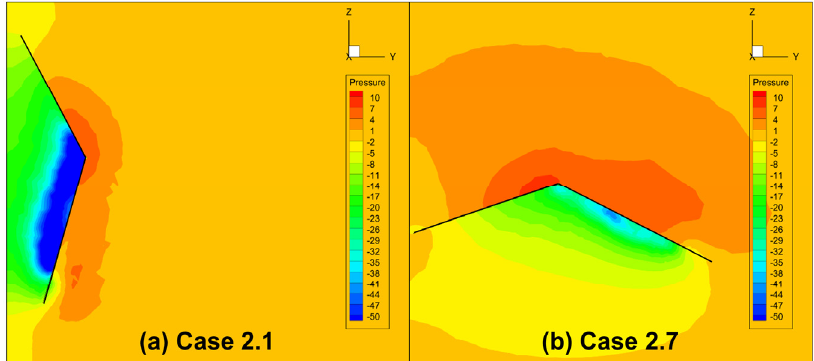
Figure 17. Pressure distribution of typical cases at t* = 0.6: ( a ) case 2.1; ( b ) case 2.7.